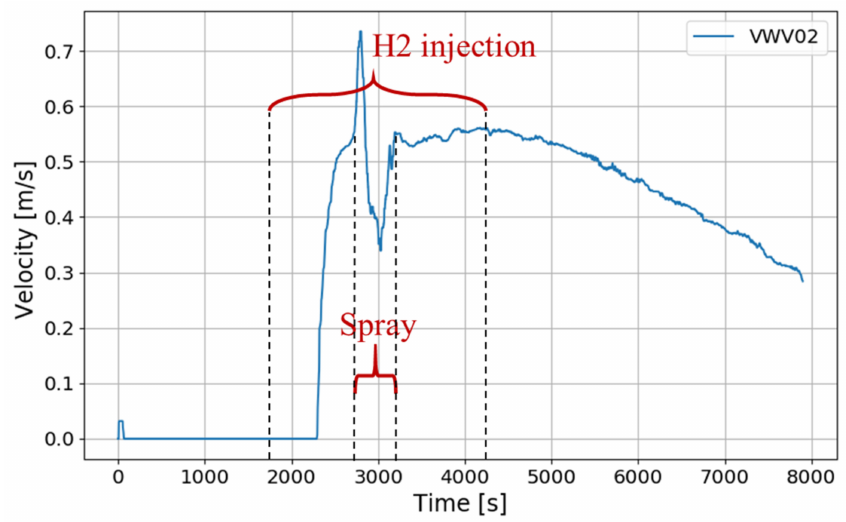
Figure 24. Time variation of the gas velocity measured at the PAR inlet during the SSP4 test.